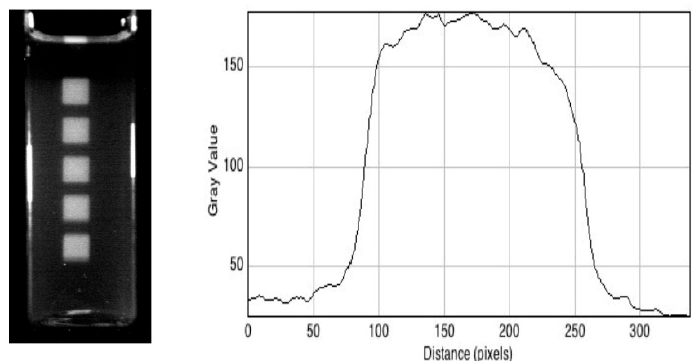
Figure 7. Left: A 20 mm square cell containing a 60 mm length of an RFG gel irradiated five times with a 5 mm square X-ray beam (dose 10 Gy) with the beams vertically displaced by 10 mm between irradiations. Right: A pixel profile scan across the central beam at 0.030 mm per pixel.